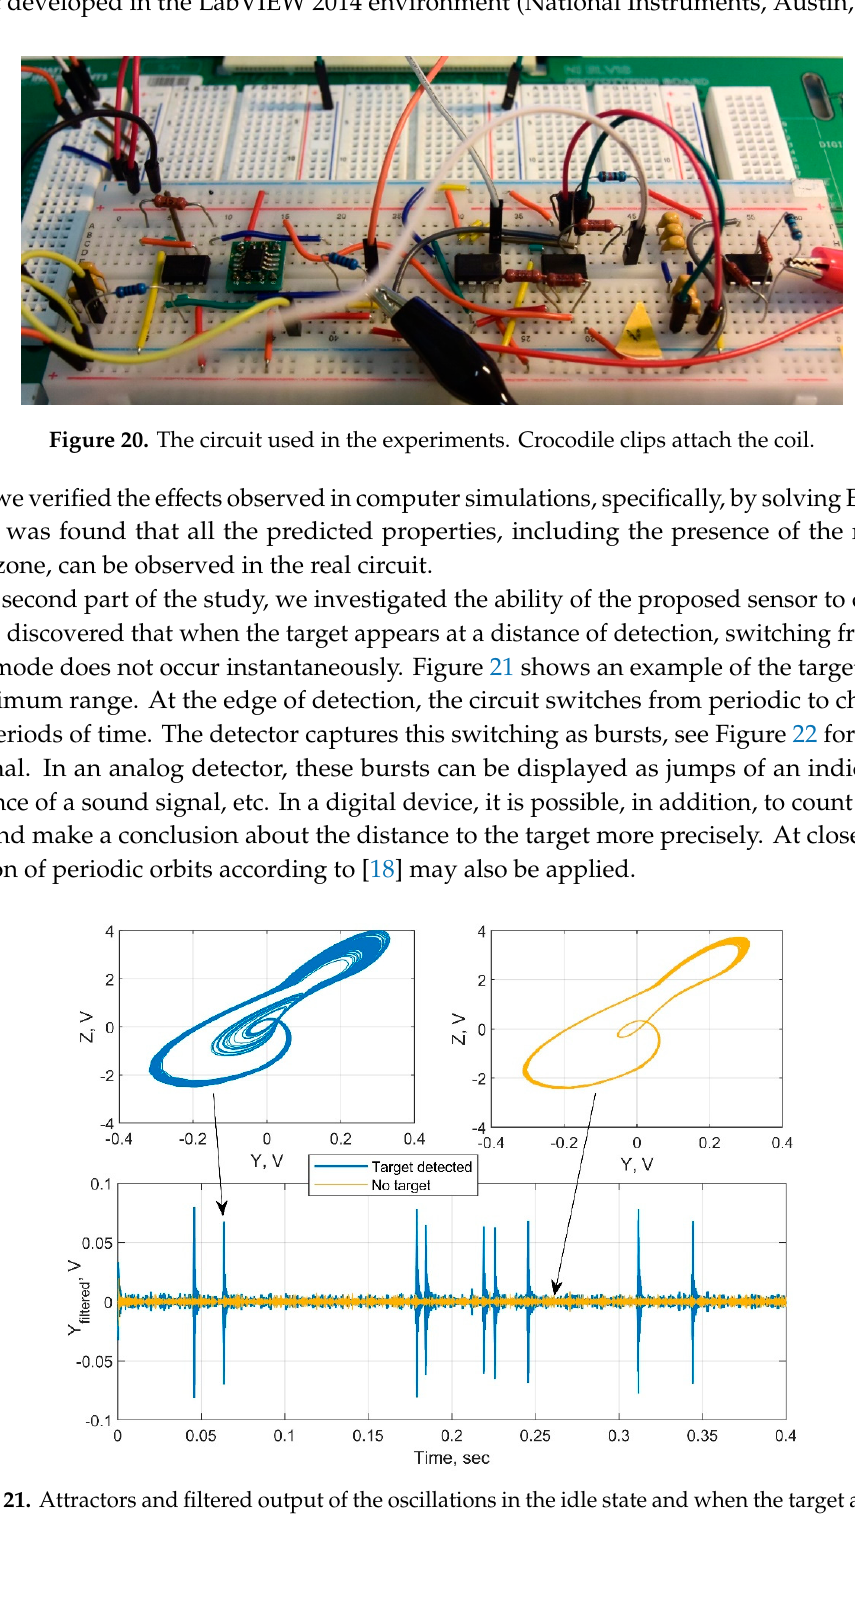
Figure 22. Closer view of the detection filter output. The chaotic mode detector is sensitive to the presence of chaos in the circuit oscillations (grey line) and it responds with the increase in amplitude (black line). Table 1 lists the detection ranges of different targets obtained for the developed sensor. These values represent the properties of the proposed sensor. An improvement of the sensor characteristics is possible, in particular, through the use of more advanced equipment, such as a very stable power source and voltage source n V .